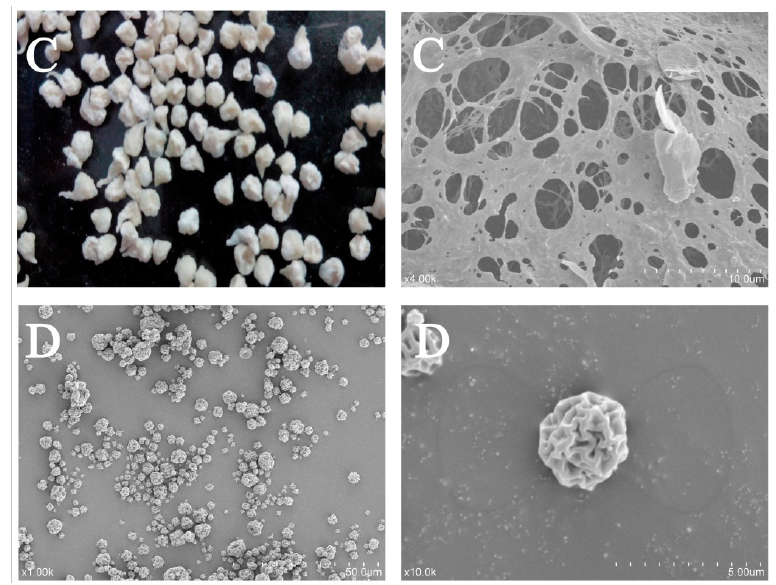
Figure 2. Scanning electron microscopy (SEM) photographs of different materials: ( A ) β -CD; ( B ) GEO/ β -CD composite; ( C ) GEO/ β -CD/CTS particles; ( D ) GEO/ β -CD/CTS microsphere.